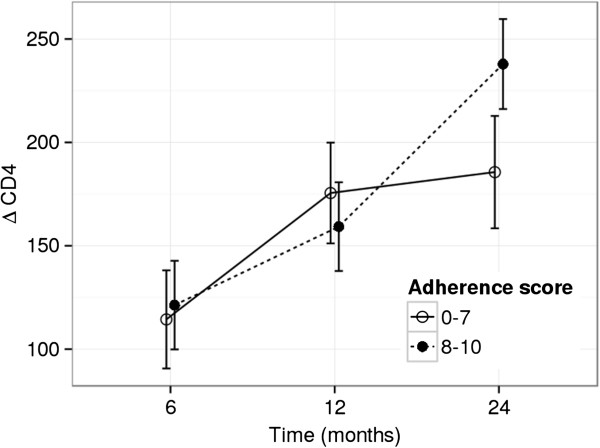
Estimated mean Δ CD4+ T cell count evolution. The plot represents estimated mean Δ CD + T counts separately for optimal (8–10) and suboptimal (0–7) adherence levels at every visit (6 months, 12 months and 24 months). Bars represent the standard error of the means.